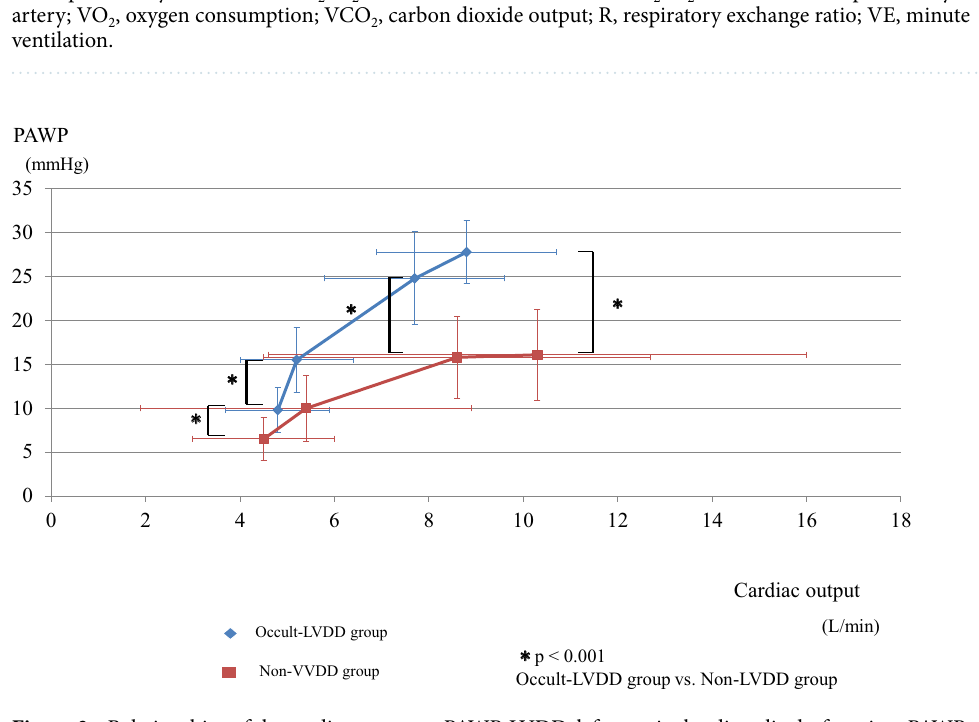
Figure 3. Relationships of the cardiac output to PAWP. LVDD, left ventricular diastolic dysfunction; PAWP, pulmonary artery wedge